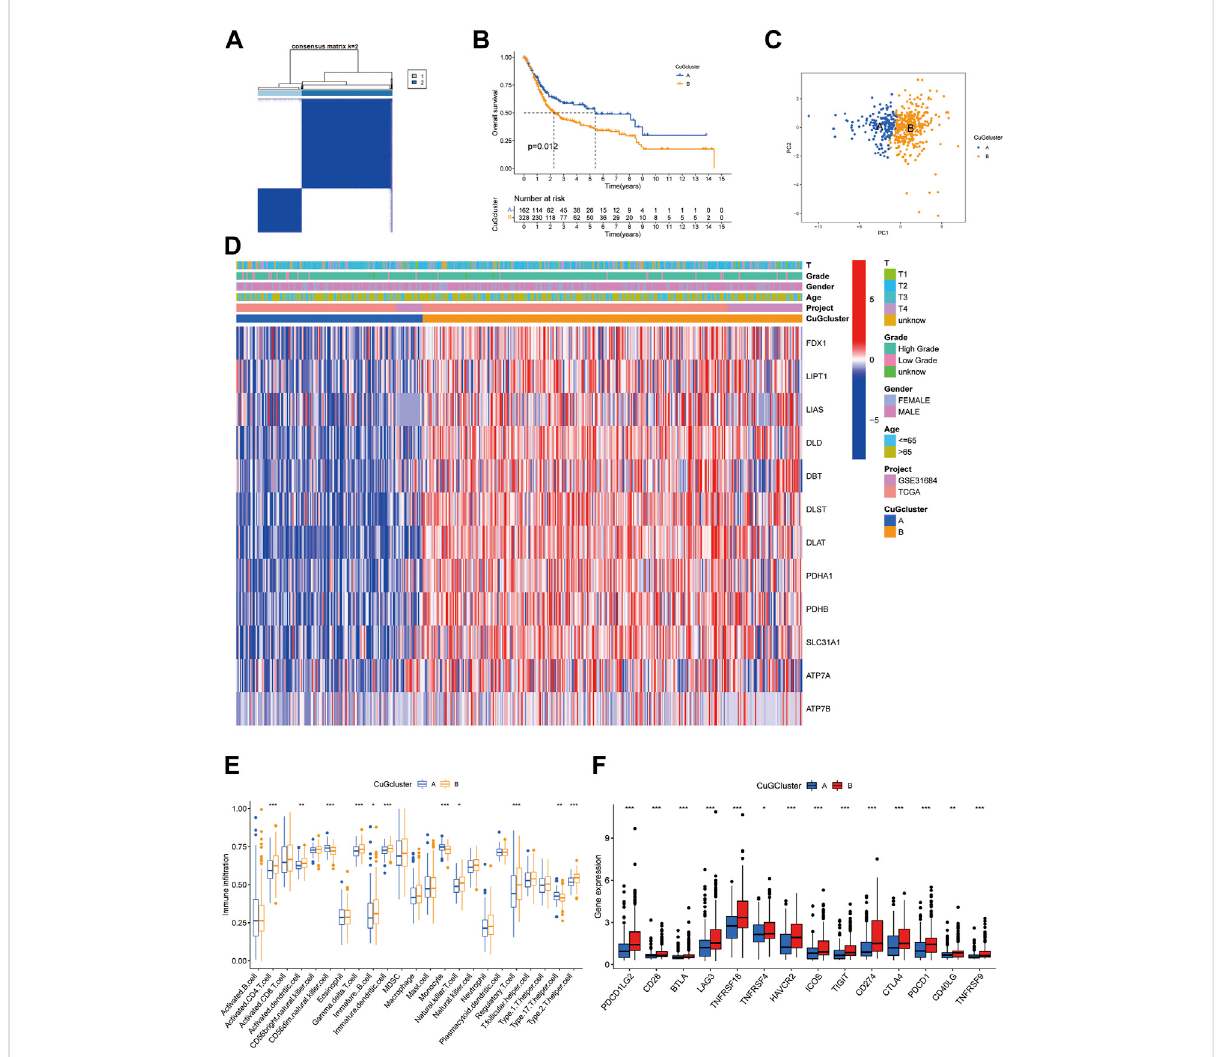
FIGURE 2 Cuproptosis-related molecular patterns with distinct survival and TME features. (A) The consensus score matrix of all the samples by unsupervised clustering analysis based on the mRNA expression pro fi les of 12 CuGs. (B) Kaplan-Meier curves for the two cuproptosis molecular patterns. (C) PCA of the two cuproptosis molecular patterns: pattern A (blue) and pattern B (orange). (D) Heatmap showed the clinical features and expression of CuGs of the two patterns. (E) Boxplot showed different immune cell in fi ltration between the two patterns by ssGSEA analysis.